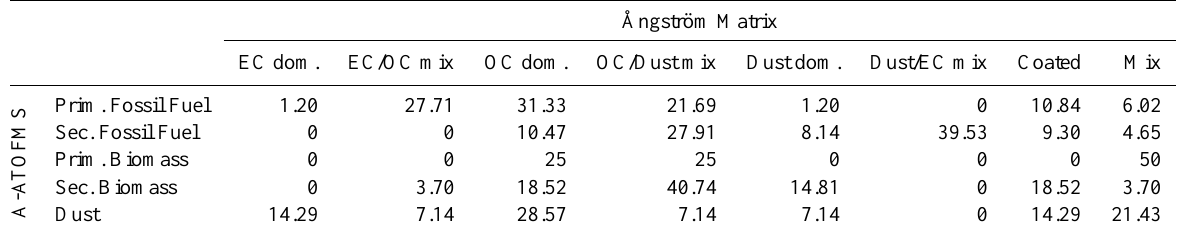
Table 3. Contingency matrix constructed from the aircraft measurements representing the percentage of aerosol sources from the A-ATOMFS classified into the different Ångström matrix classes. Ångström Matrix EC dom. EC/OC mix OC dom. Dust